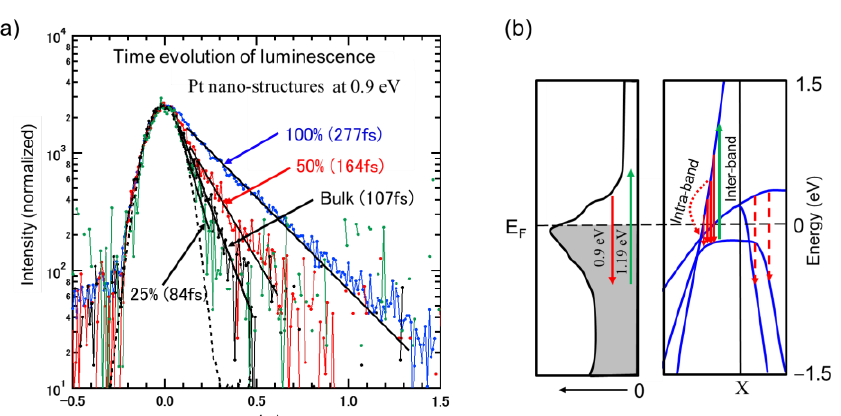
Fig. 2 (a) Excitation power dependence of the luminescence decay profiles taken at 0.9 eV in Pt nano- structures. 100% corresponds to a power of 145 mW on the sample. The decay profile of bulk Pt at 100% excitation is also shown. The straight lines are exponential fittings to each decay curve with time constants shown in the parentheses. The broken curve shows the instrumental function. (b) Density of states and a part of the band structure near X point for bulk Pt.[6] Transitions corresponding to absorption and emission are shown by upward and downward arrows,